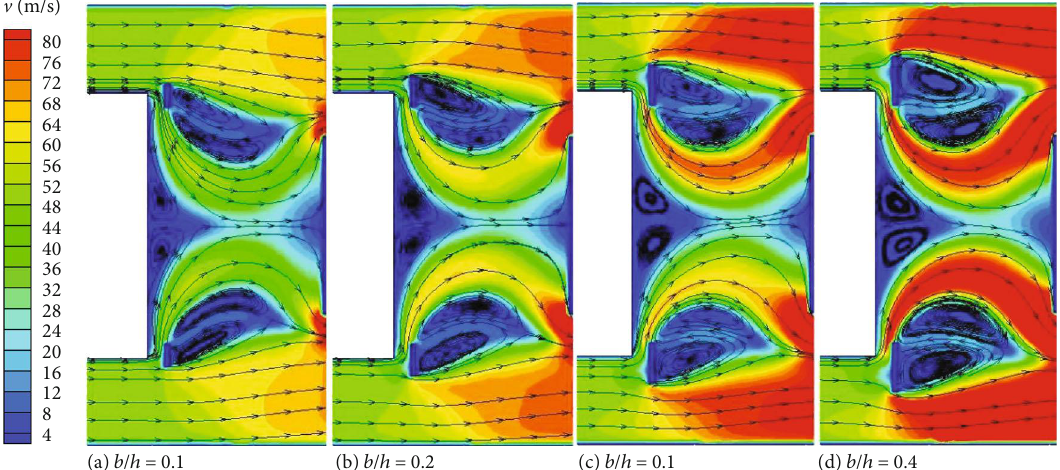
Figure 11: Velocity in the cavity at section Z = 0 mm under di ff erent b / h .